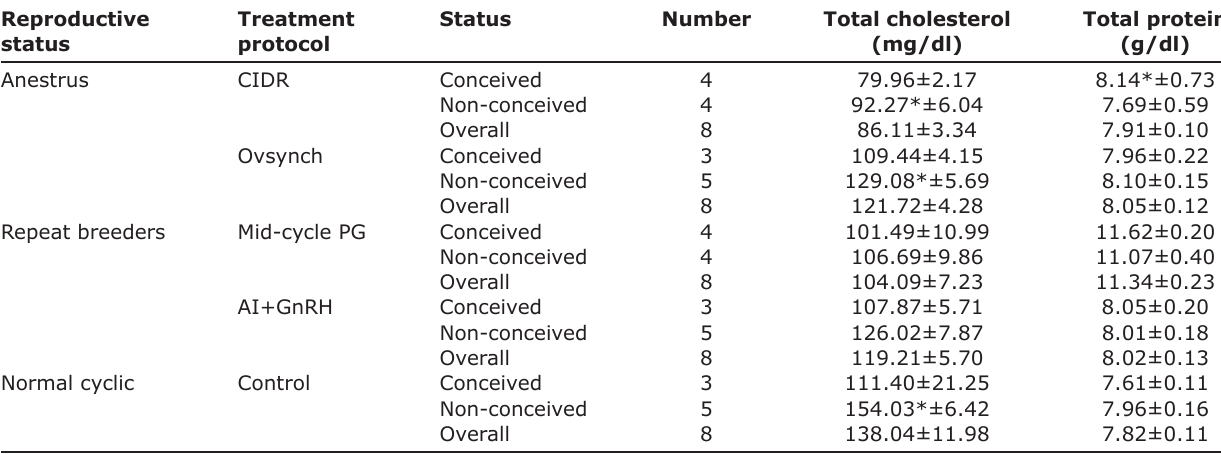
Table 2: Mean plasma total cholesterol concentrations (mg/dl) in anestrus and repeat breeding buffaloes conceiving and not conceiving following various treatment protocols and in normal control group. Reproductive